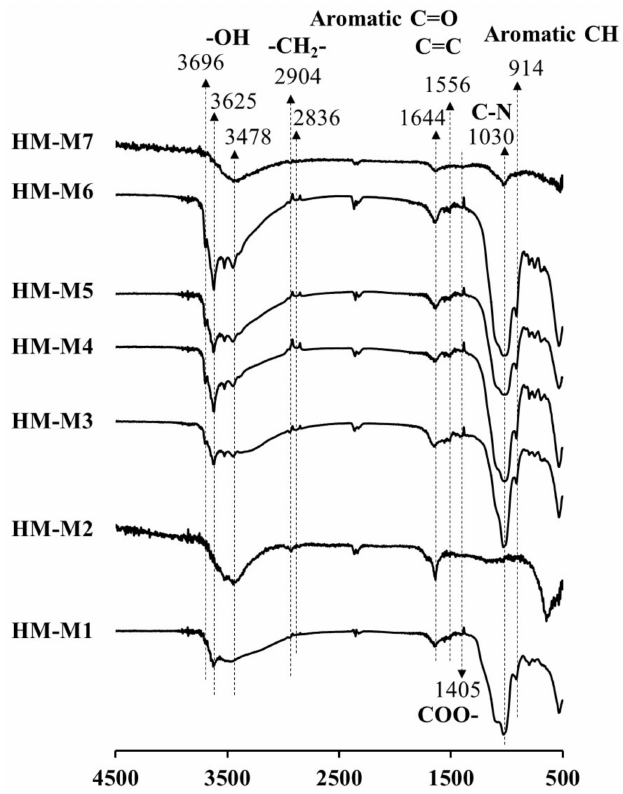
Figure 3. Fourier transform infrared (FT-IR) spectra of humin (HM) isolated from Kamajima paddy soil using different